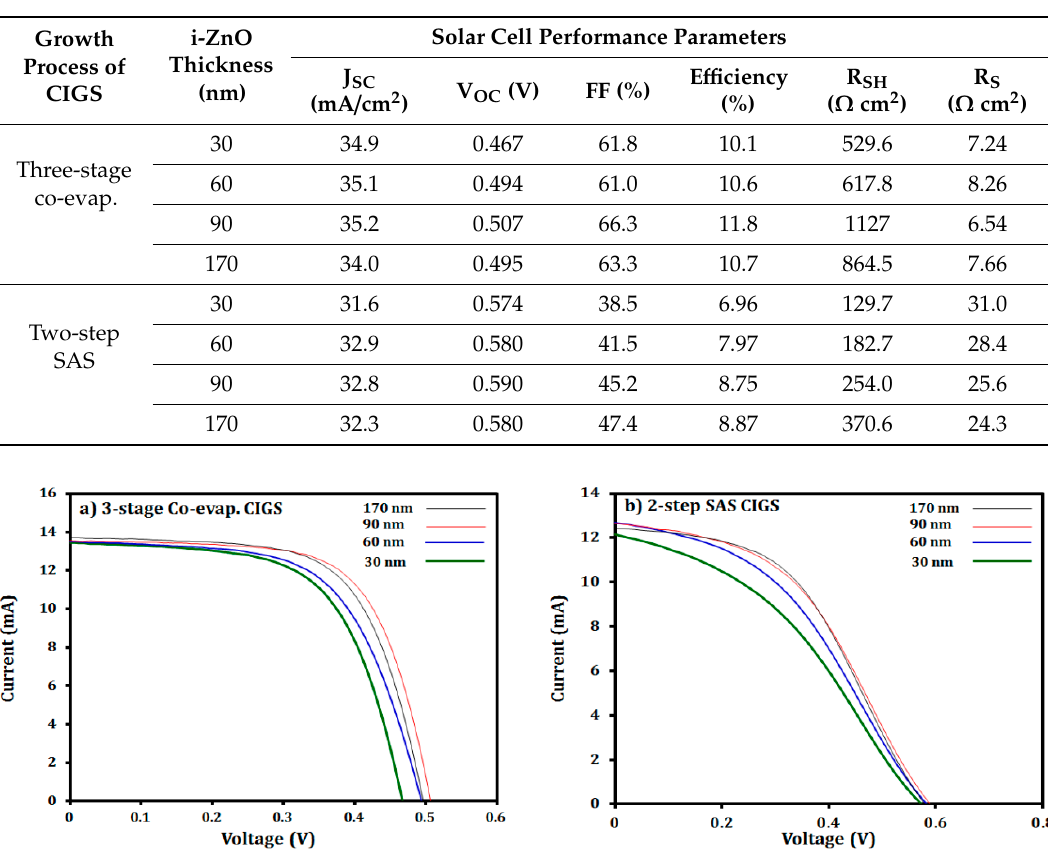
Figure 11. Current and voltage characteristics of the CIGS solar cells with different i-ZnO thicknesses and different CIGS absorbers: ( a ) three-stage co-evaporation CIGS and ( b ) two–step SAS CIGS.